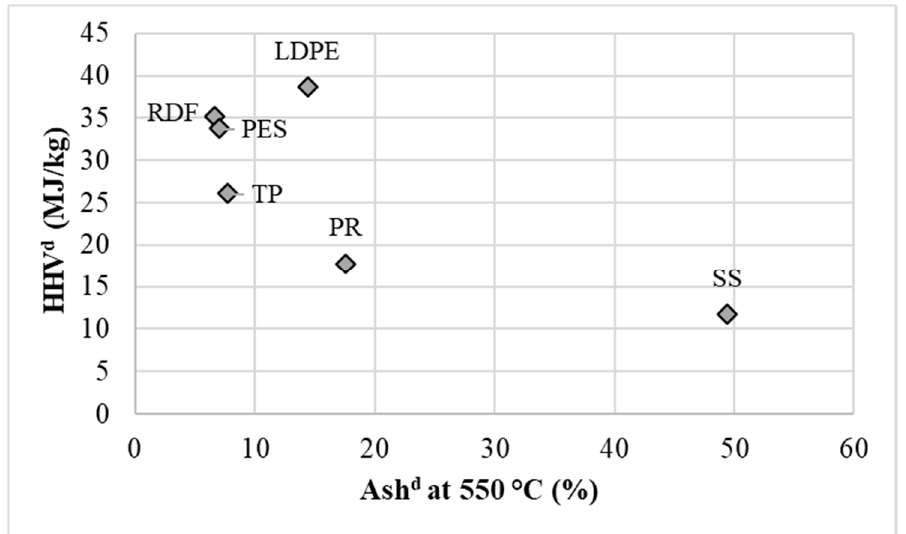
Figure 4. The HHV d (MJ/kg) and ash d at 550 °C (%), d means in dry matter. Certain studied plastics, such as RDF, TP and LDPE, have higher volatile matter and weight loss than PR, PES and SS, so there is more chance of the decomposition of volatile matter, and in turn high oil and gas yields (Figure 5) [10].